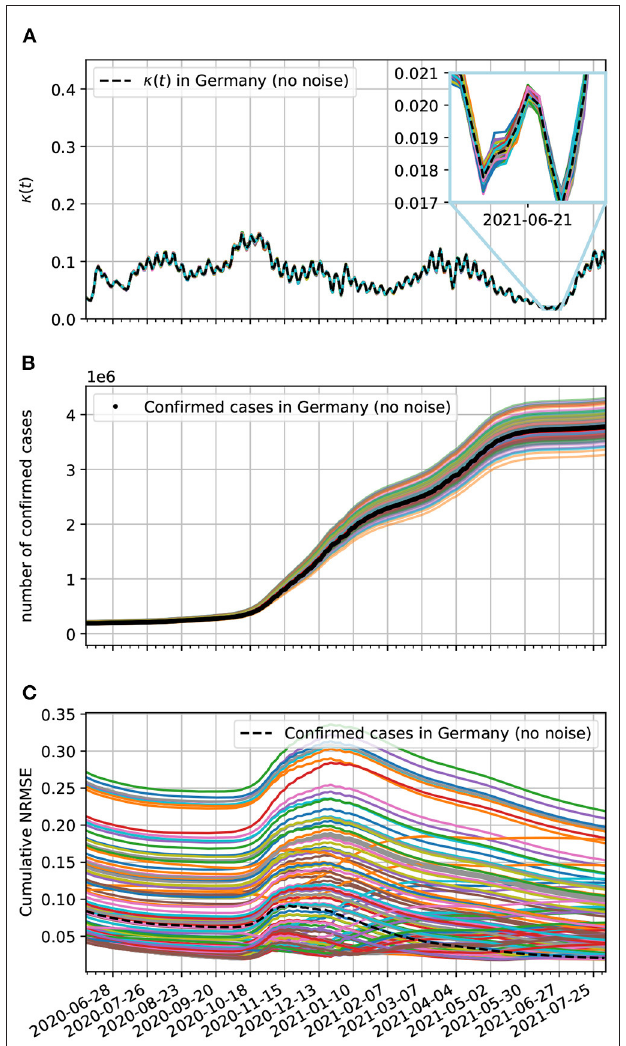
FIGURE 12 | (A) Contagion rate estimation of the theoretical model based on epidemiological data from Germany with added noise. (B) Comparison of our theoretical model estimates with the epidemiological data from Germany. Here, the epidemiological data reporting uncertainties are accounted for by the added Gaussian noise with zero mean and a daily standard deviation of 5 % on the data. All curves without labels are estimates for the epidemiological data with added Gaussian deviates. (C) Cumulative normalized NRMSE of confirmed cases with added Gaussian noise. The minimum time interval used was 90